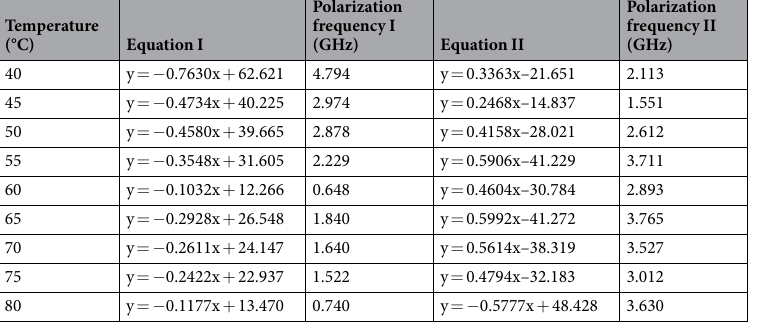
) varying with ε′ with rapid conventional